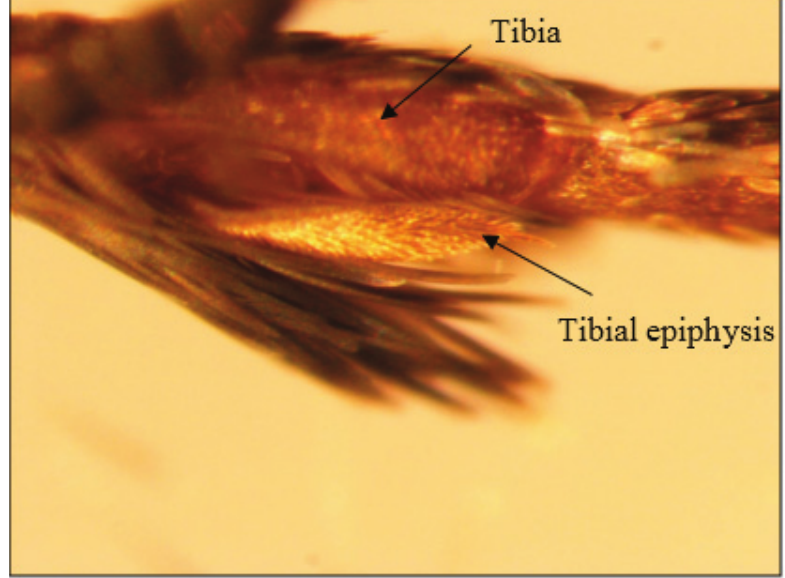
Figure 3. Image of the brush-like tibial epiphysis on the fore tibia of Plodia interpunctella females that may be involved in grooming the antennae during oviposition. The image was recorded using an Olympus SZX stereo microscope (Olympus America Inc., Center Valley, PA, USA) at 115× magnification. Note that the scales on the fore tibia were removed before the image was taken.